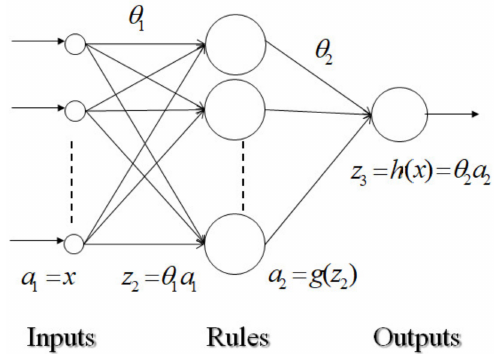
Figure 1. The schema of the fuzzy logic